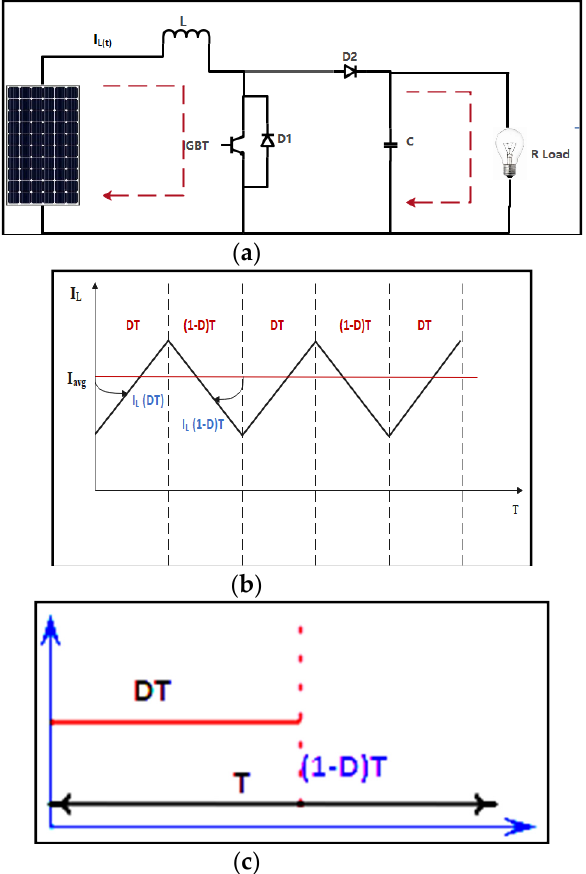
Figure 8. Circuit diagram, waveform and duty cycle of DC–DC boost convertor (conduction state) ( a ) circuit diagram; ( b ) the waveform of DC–DC boost convertor with their average; ( c ) duty cycle.